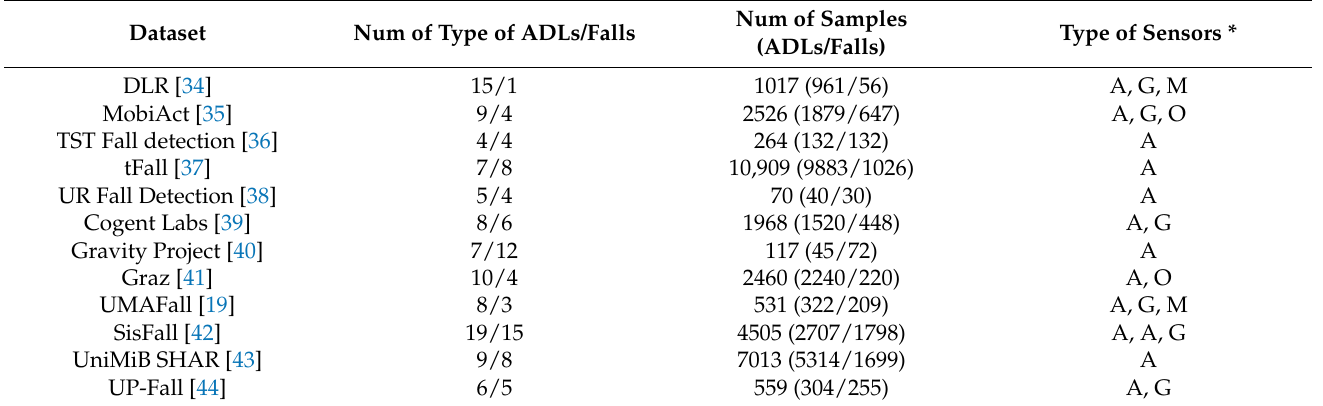
Table 2. The details of publicly available fall datasets.